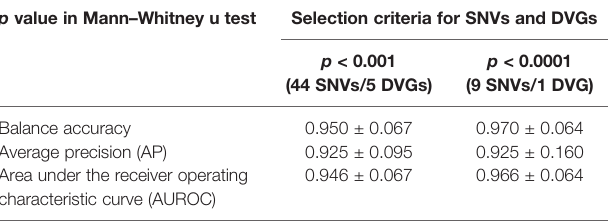
TABLE 3 | Comparison of ML models by 10-fold cross-validation for disease severity prediction in DENV 2